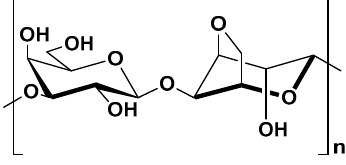
Figure 14. Chemical structure of